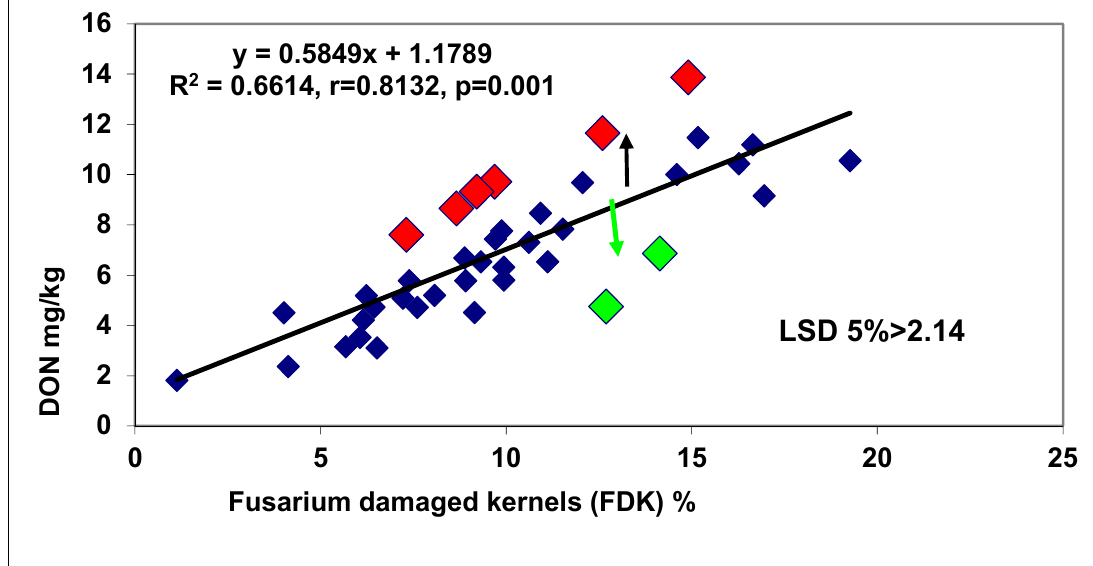
Figure 13. FDK and DON regression in FHB resistance tests in winter wheat genotypes against two F. graminearum and two F. culmorum strains, 2009–2012. Red data: FDK overproduction, data from the regression line are farer than the LSD 5% 2.14 to the larger DON concentrations; green data: resistance to kernel infection, data from the regression line are farer than the LSD 5% 2.14 to the lower DON concentrations. LSD 5%: for DON is 2.14 [26].